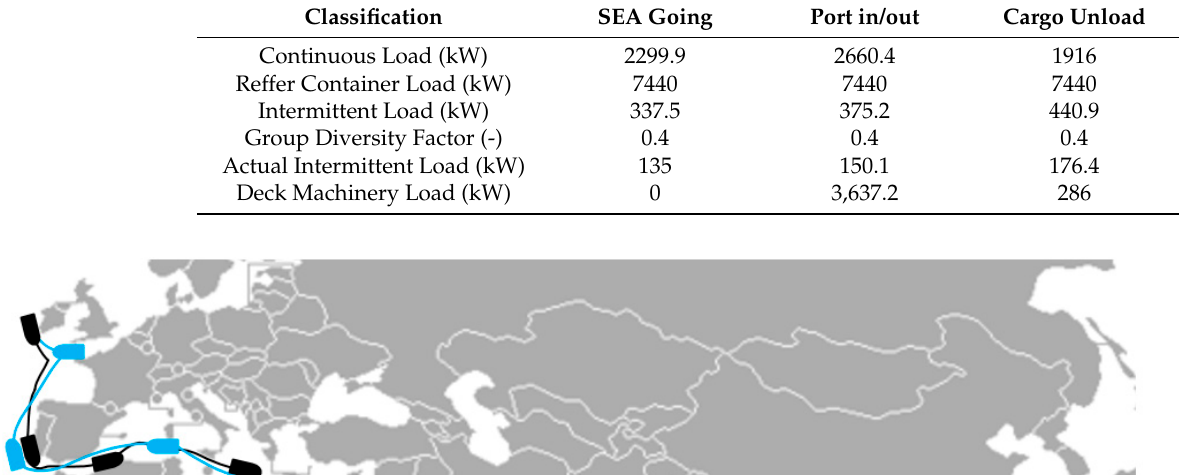
Table 2. List of electrical loads.